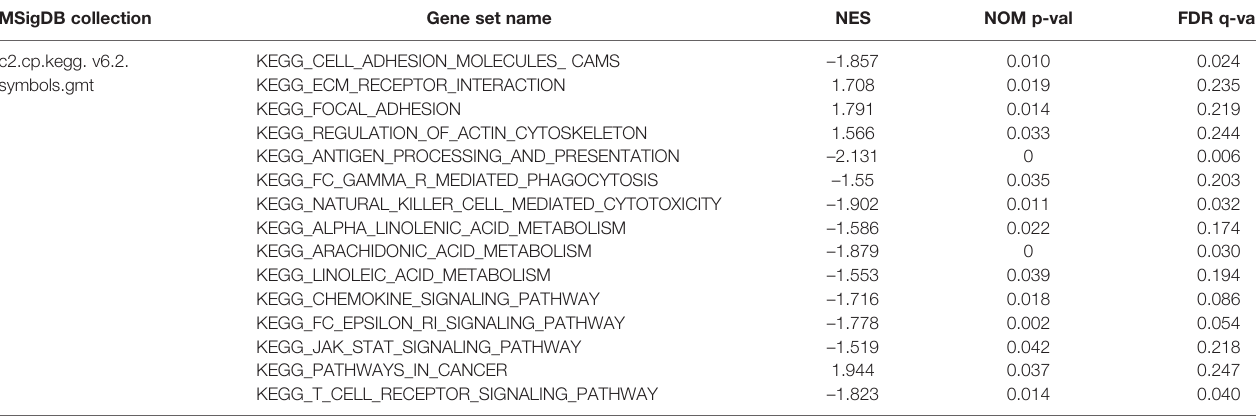
TABLE 3 | Gene sets enriched in risk